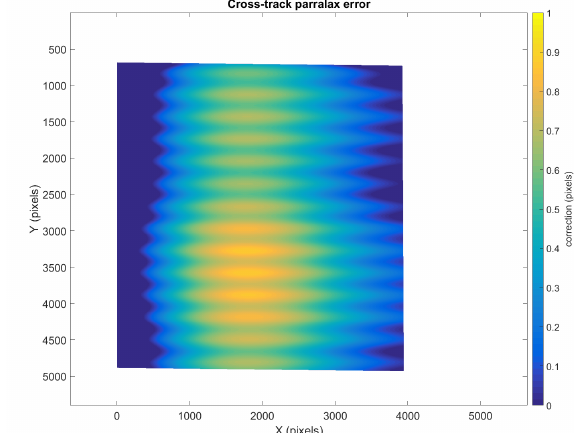
Figure 4: Measure of the combined cross-track vibration visible in the back-looking image through bi-dimensional correlation in back-looking image coordinates for the 2014 scene presented in section 3.1.